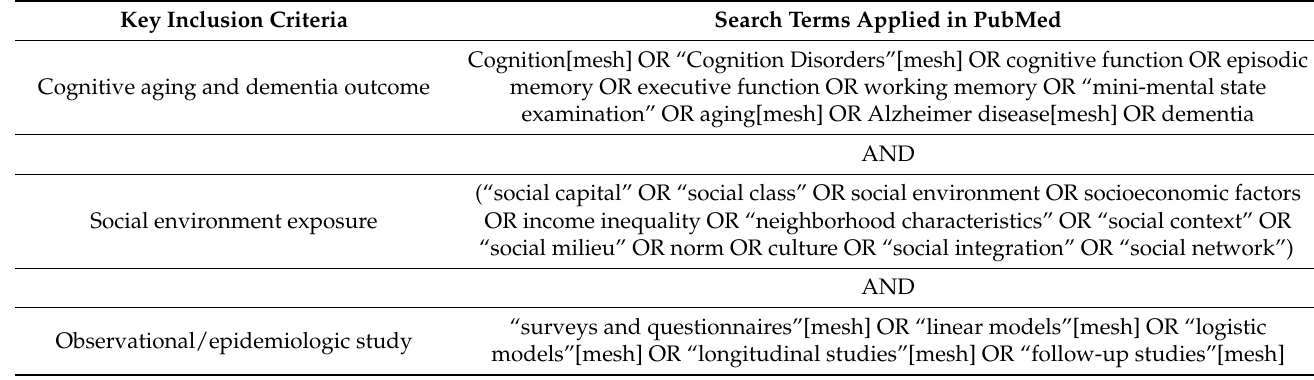
Table 1. Search criteria and terms implemented in the PubMed and Web of Science databases from inception through October 2020, limited to English language peer-reviewed